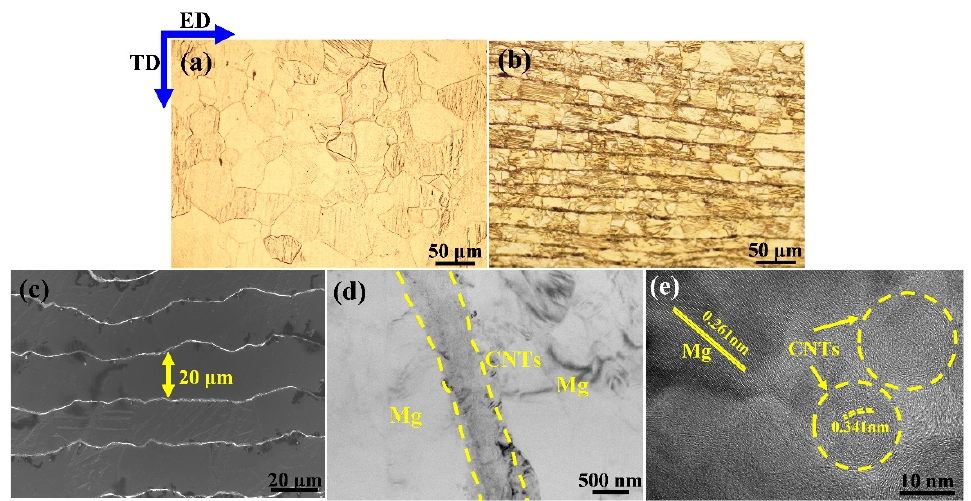
Figure 3. Microstructure of as-extruded laminated CNTs/Mg composite. ( a , b ) OM image of bulk Mg and CNTs/Mg composite on ED-TD plane, respectively; ( c ) SEM photograph of laminated CNTs/Mg composite on ED-TD plane with adjacent CNTs layers spacing ~20 μ m; ( d ) TEM image from ED-TD plane of hot-extruded CNTs/Mg composite; ( e ) HRTEM image demonstrates the interface between Mg matrix and CNTs.